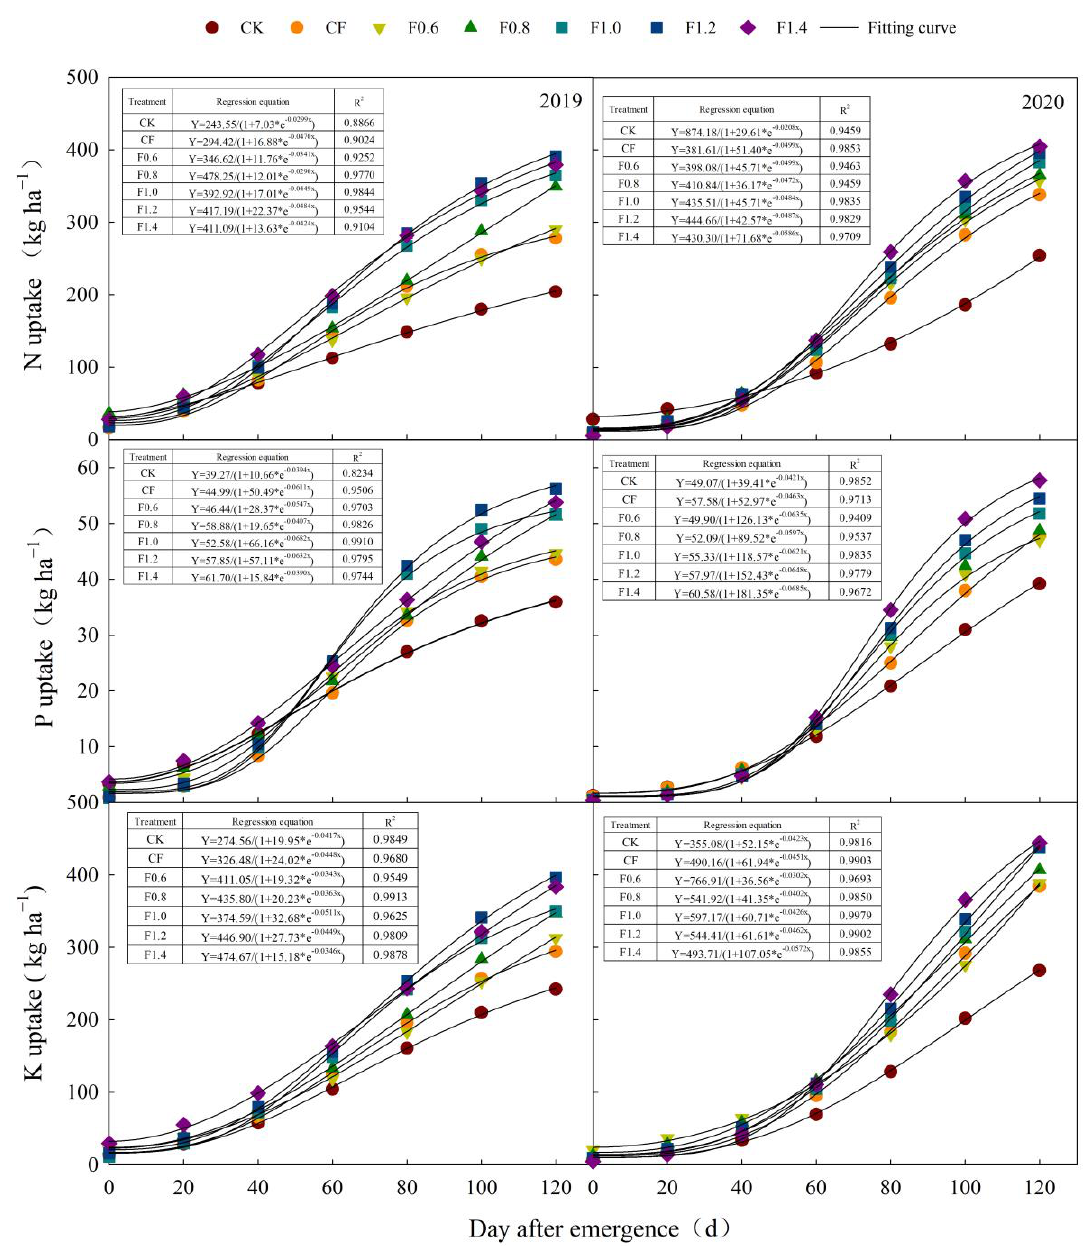
Figure 3. Changes in N, P and K accumulation in cotton plants under different fertilization in both years.